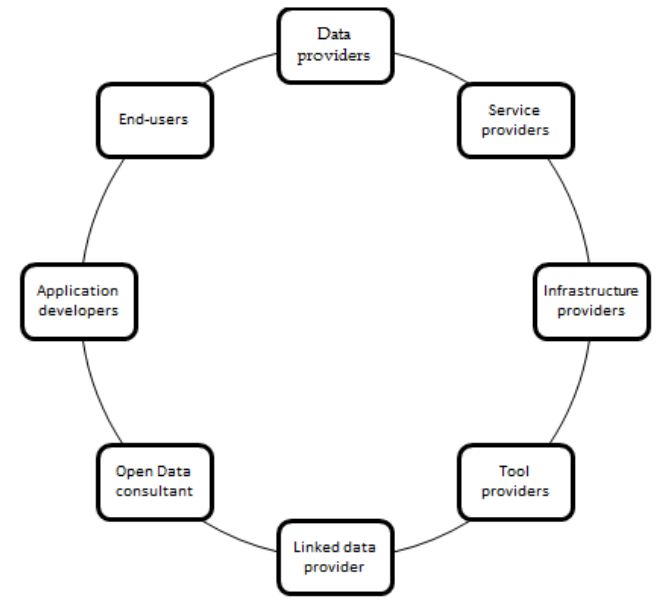
Figure 1. Actors of the open data value network.